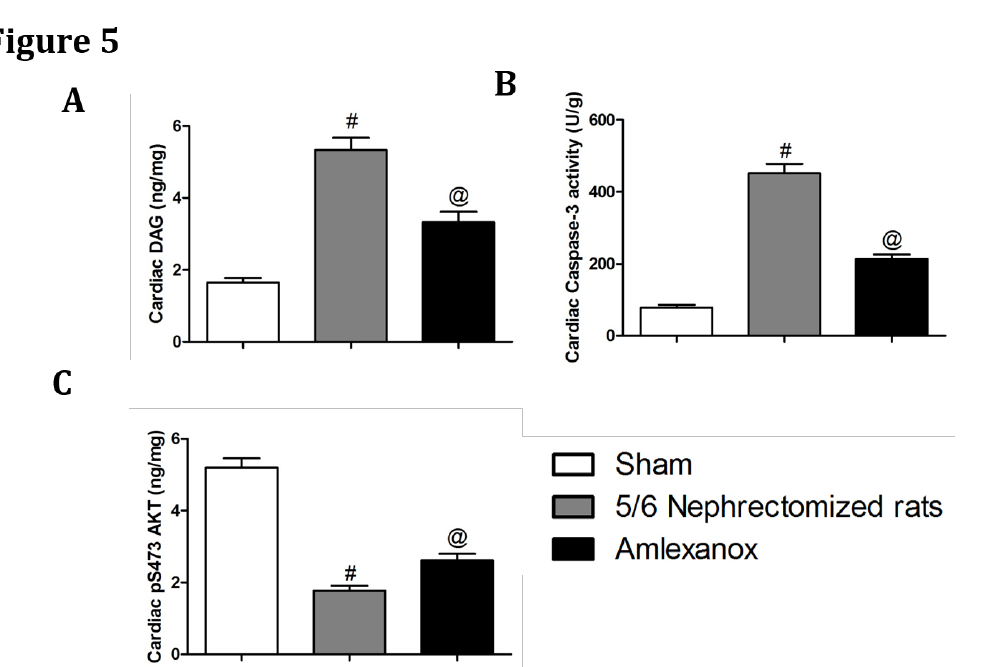
FIGURE 5 - Changes in cardiac diacylglycerol (DAG) and apoptosis signals. (A ) Quantitative analysis of diacylglycerol (DAG). (B ) Quantitative analysis of caspase-3 activity. (C) Quantitative analysis of pS473AKT. Amlexanox (25 mg/kg/day) was injected i.p. for 10 weeks, starting just after 5/6 nephrectomy. Groups were compared using one-way ANOVA and post-hoc Tukey’s test. Values are represented as mean ± SE (n = 6). #P < 0.05 compared with the sham group, @ P < 0.05 compared with the 5/6 nephrectomy